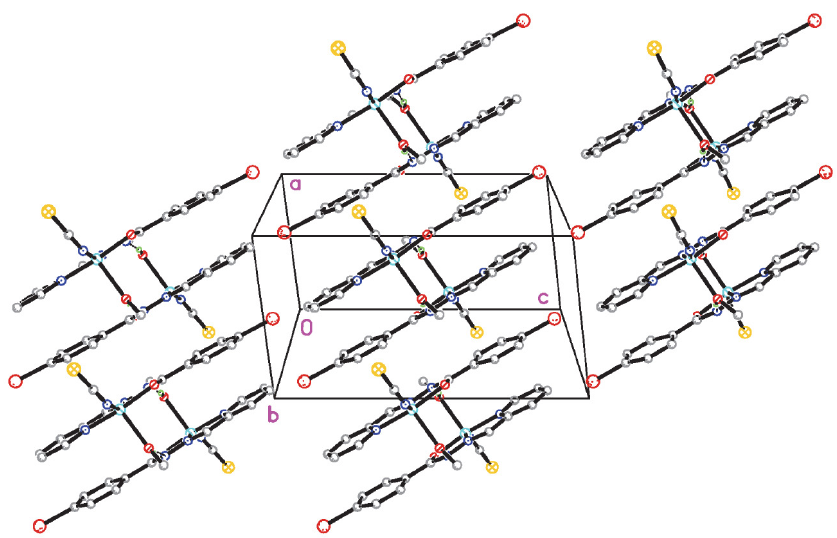
Figure 4. Molecular packing structure of 1 , viewed along the b axis. Hydrogen bonds are shown as dashed